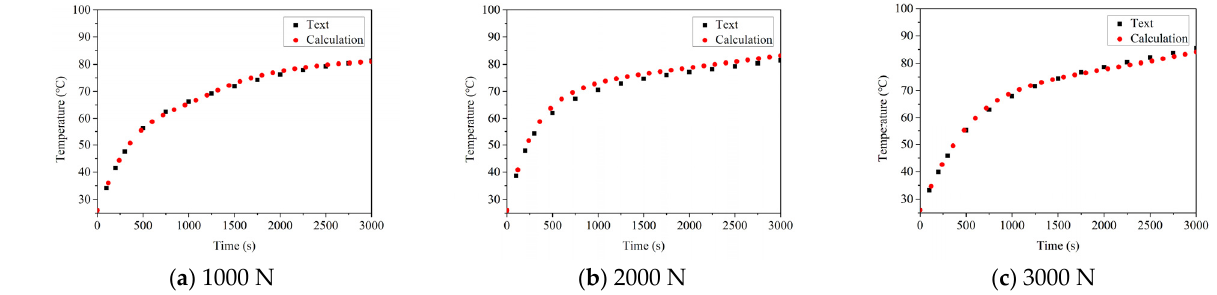
Figure 11. The influence of the load on temperature change of damaged bearing.